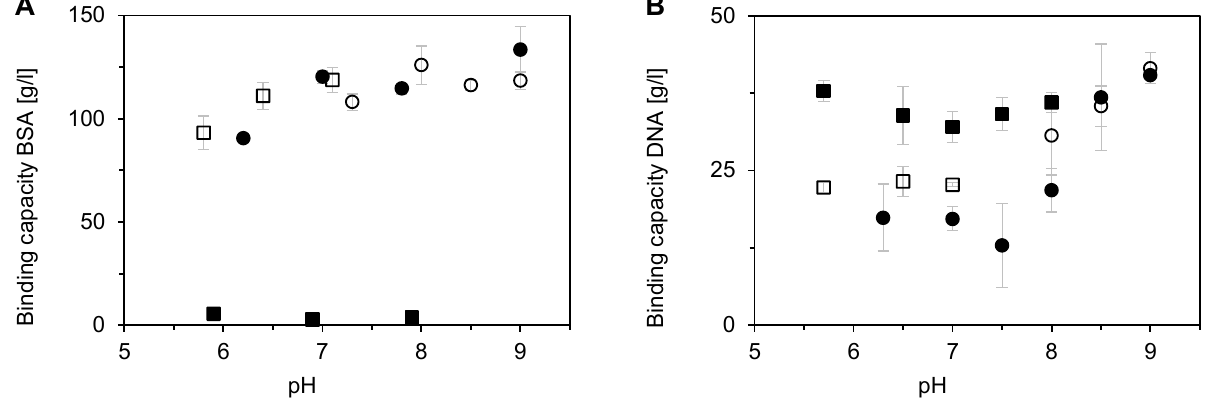
Figure 4. Influence of pH on single-component adsorption of BSA ( A ) and DNA ( B ) on Sartobind STIC using a micromembrane module with centrifuge-forced flow. Symbols represent effect of: ( □ ) bis-tris buffer, ( ● ) bis-tris propane buffer, ( ○ ) tris buffer, and ( ■ ) phosphate buffer. Error bars represent standard deviations.